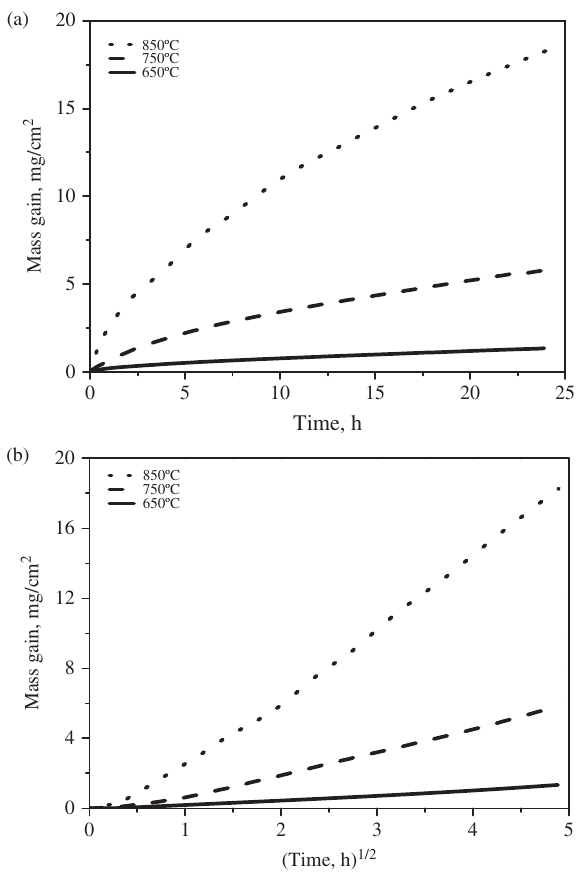
Figure 3: Kinetic curves for the oxidation of Ti-6Al-4V in air at 650, 750 and 850°C for 24 h: (a) linear plots; (b) parabolic plots.